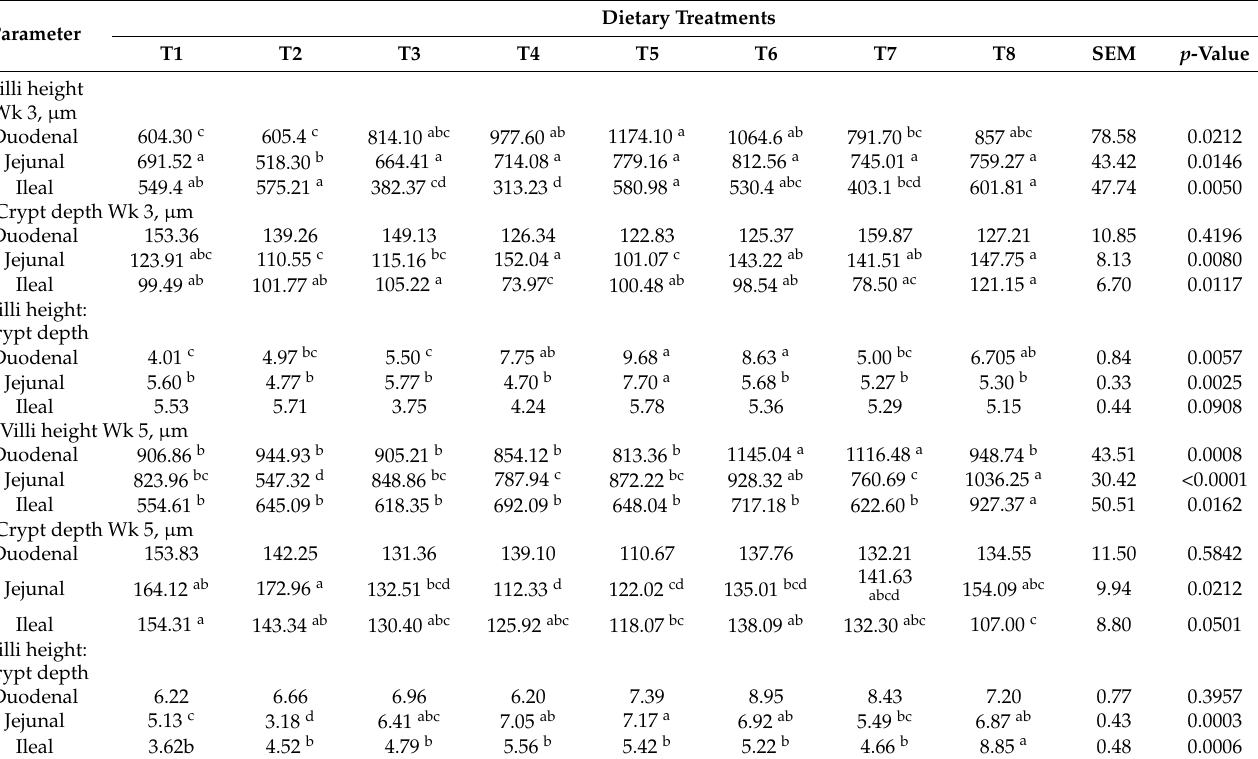
Table 6. Histomorphology of small intestine in broiler chicken fed postbiotics and